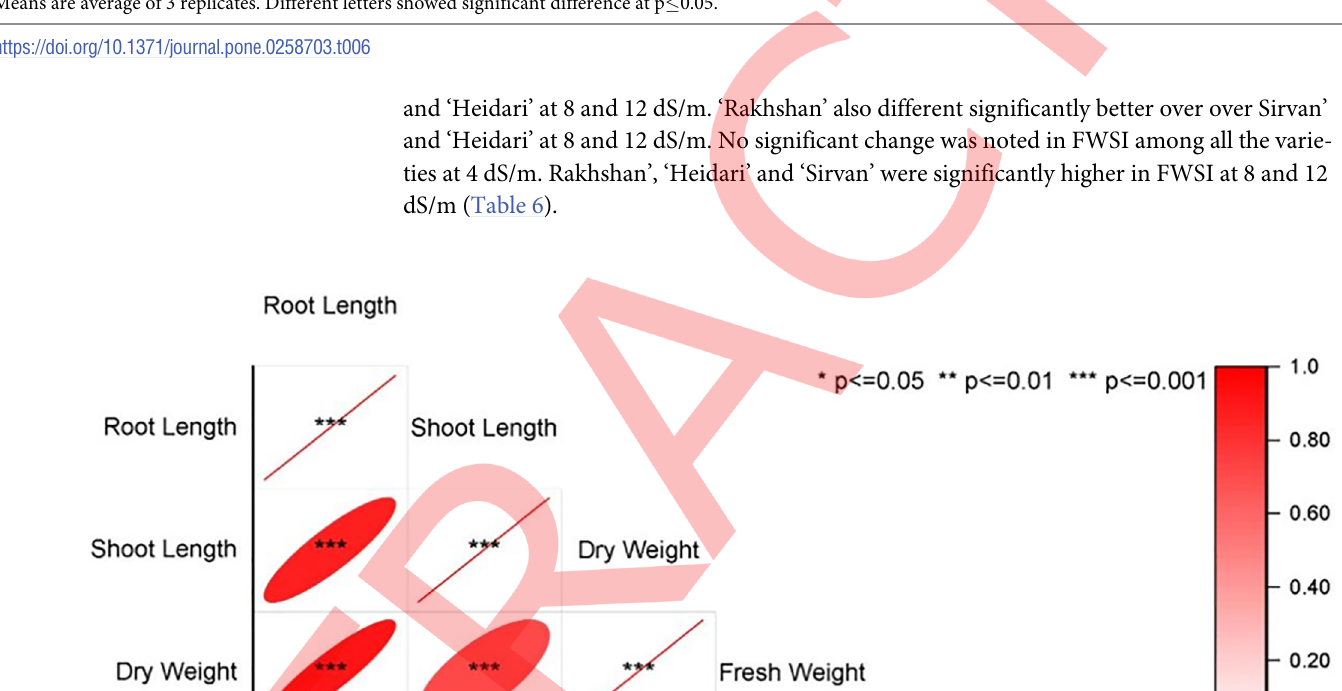
Means are average of 3 replicates. Different letters showed significant difference at p � 0.05.